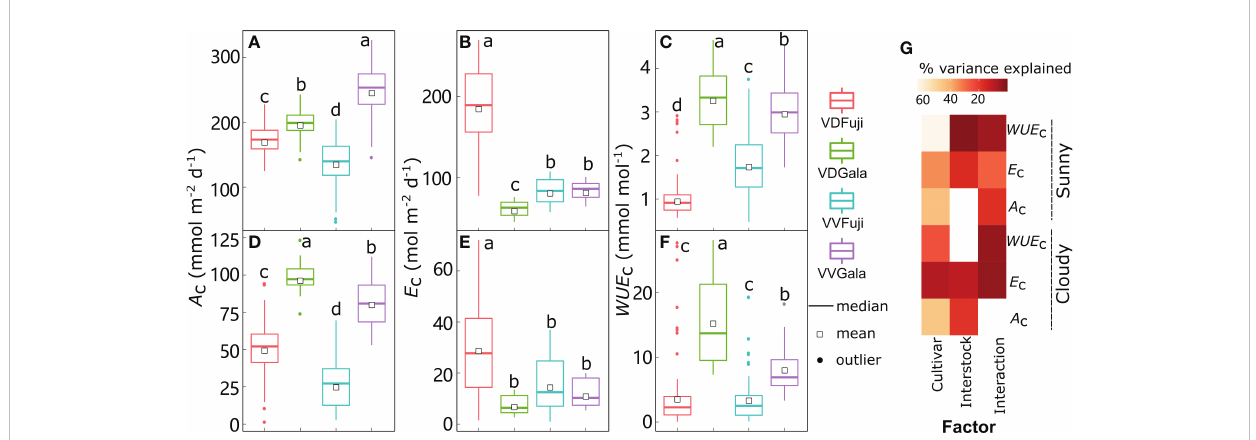
FIGURE 8 Boxplot of daily canopy net photosynthesis rate ( A c ) (A, D) , transpiration rate ( E c ) (B, E) , and water use ef fi ciency ( WUE c ) (C, F) under sunny (A – C) and cloudy (D – F) conditions in ‘ Fuji ’ and ‘ Gala ’ apple trees grafted on a vigorous rootstock associated either with a dwarf M26 interstock (VD) or a vigorous ‘ Qinguan ’ interstock (VV), with corresponding amounts of variances in A c , E c and WUE c explained by cultivar, interstock, and their interaction (G) . The percent variance explained by each factor in the model is indicated using color for those factors that explain a signi fi cant portion of the variance ( p < 0.05) and different letters indicate signi fi cant differences at p <